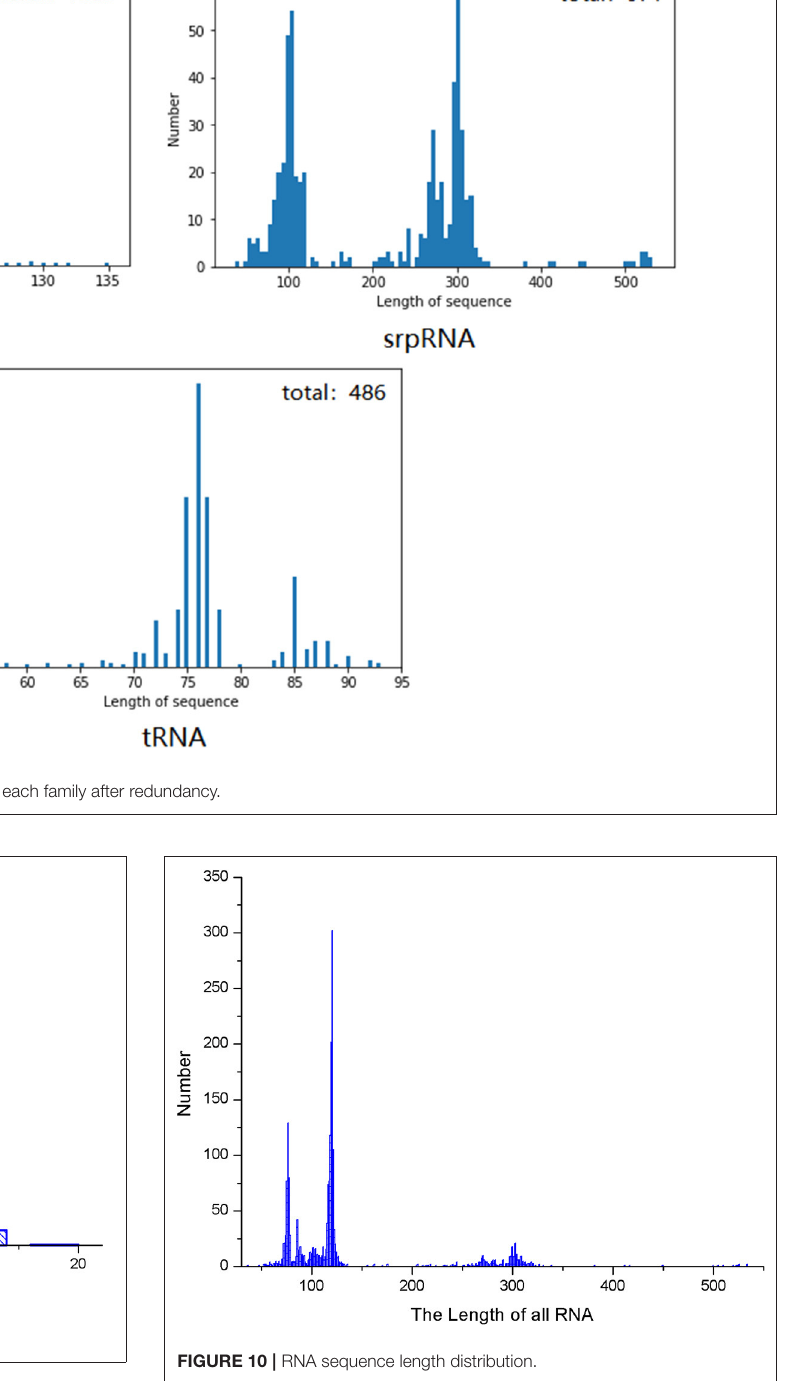
FIGURE 10 | RNA sequence length